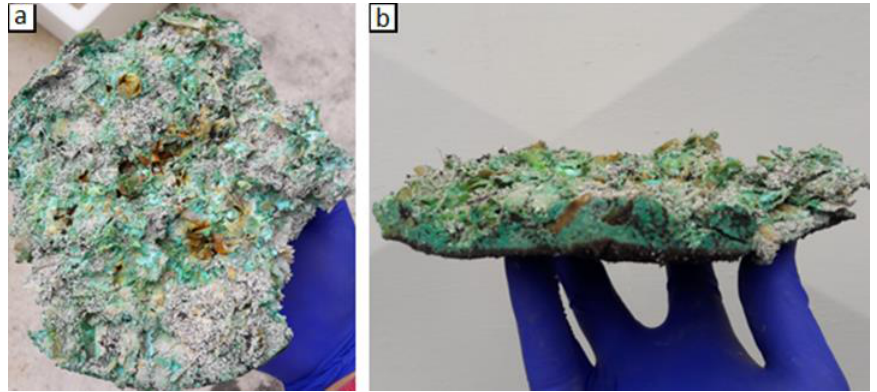
Figure 6. Formed in the DAS reactor: ( a ) front view; ( b ) side view.